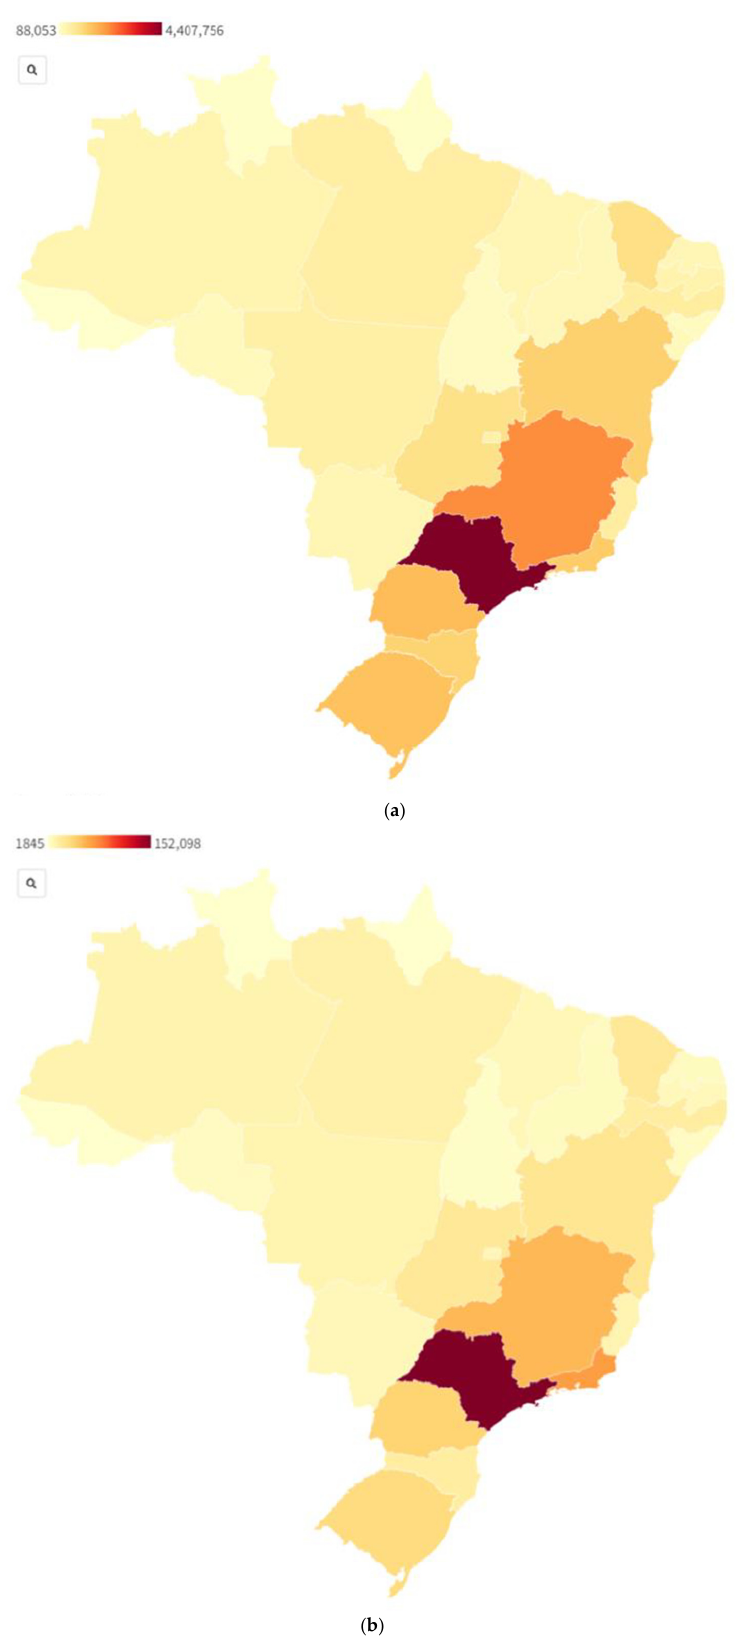
Figure 1. Confirmed COVID ‐ 19 cases ( a ) [48] and deaths ( b ) [49] by state as of 4 November 2021, Brazil. As seen in Table 1 and Figure 1, São Paulo is the state with the highest numbers of reported COVID ‐ 19 cases and deaths, almost twice those of its neighboring states (Minas Gerais and Rio de Janeiro for cases and deaths, respectively). At a regional level, the Southeast has experienced over a third (39%) of all cases and close to half of all deaths (48%). In comparison, the North has recorded just 8.5% of cases and 7.7% of deaths. These numbers should be interpreted in a demographic context, with the Southeast having a larger population and containing cities such as São Paulo and Rio de Janeiro. In the absence of safe and approved pharmaceutical products, the strategy to curb transmission of COVID ‐ 19 focused on nonpharmaceutical interventions (NPI) until safe vaccines and therapeutics were not only developed but also became more widely accessi ‐ ble. The aim of NPIs is to slow down the spread and transmission of COVID ‐ 19. In ad ‐ vance of new treatments being developed and registered for COVID ‐ 19, Brazil endorsed a regimen of unevidenced drugs including hydroxychloroquine and erythromycin under the name “kit ‐ COVID” [31]. In Brazil, the implementation of NPIs has been uneven, un ‐ coordinated, and generally unsupported at a federal level, which may have contributed to the rapid spread of the epidemic across the country [50]. COVID ‐ 19 was declared a public health emergency by Brazil on 3 February 2020 [51]; however, as previously men ‐ tioned, the federal response to COVID ‐ 19 lacked a nationwide social distancing policy, leaving state governments to play a decisive role in designing and enforcing NPIs. The federal response has primarily been shaped by the political leadership’s ideology, which has prioritized opening the economy and downplaying the severity of the pandemic and